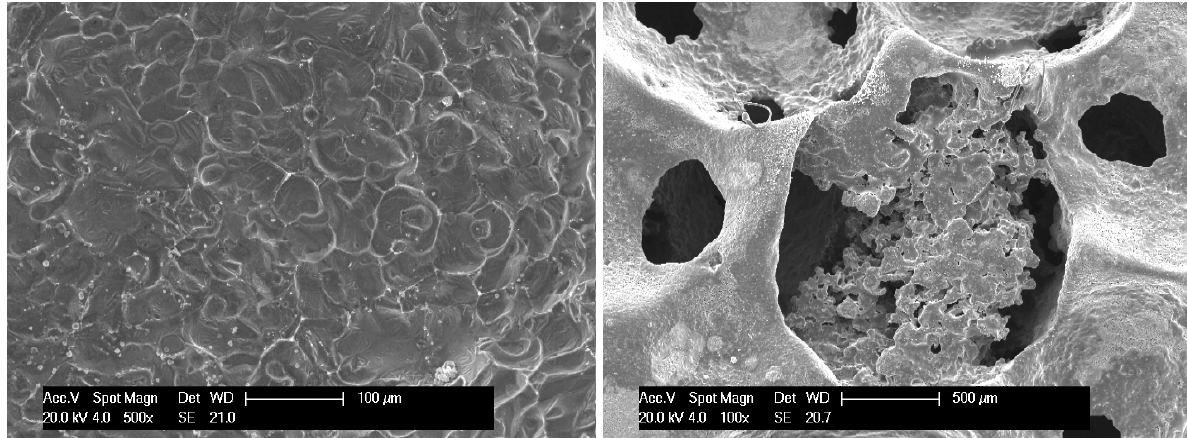
Figure 10. SEM images of (left) the cell wall surface showing replication of the nodular surface of the beads and (right) the strut morphology and morphology of the metal intruded into the